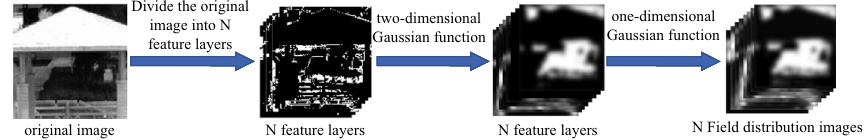
Fig. 7 Field distribution image calculation